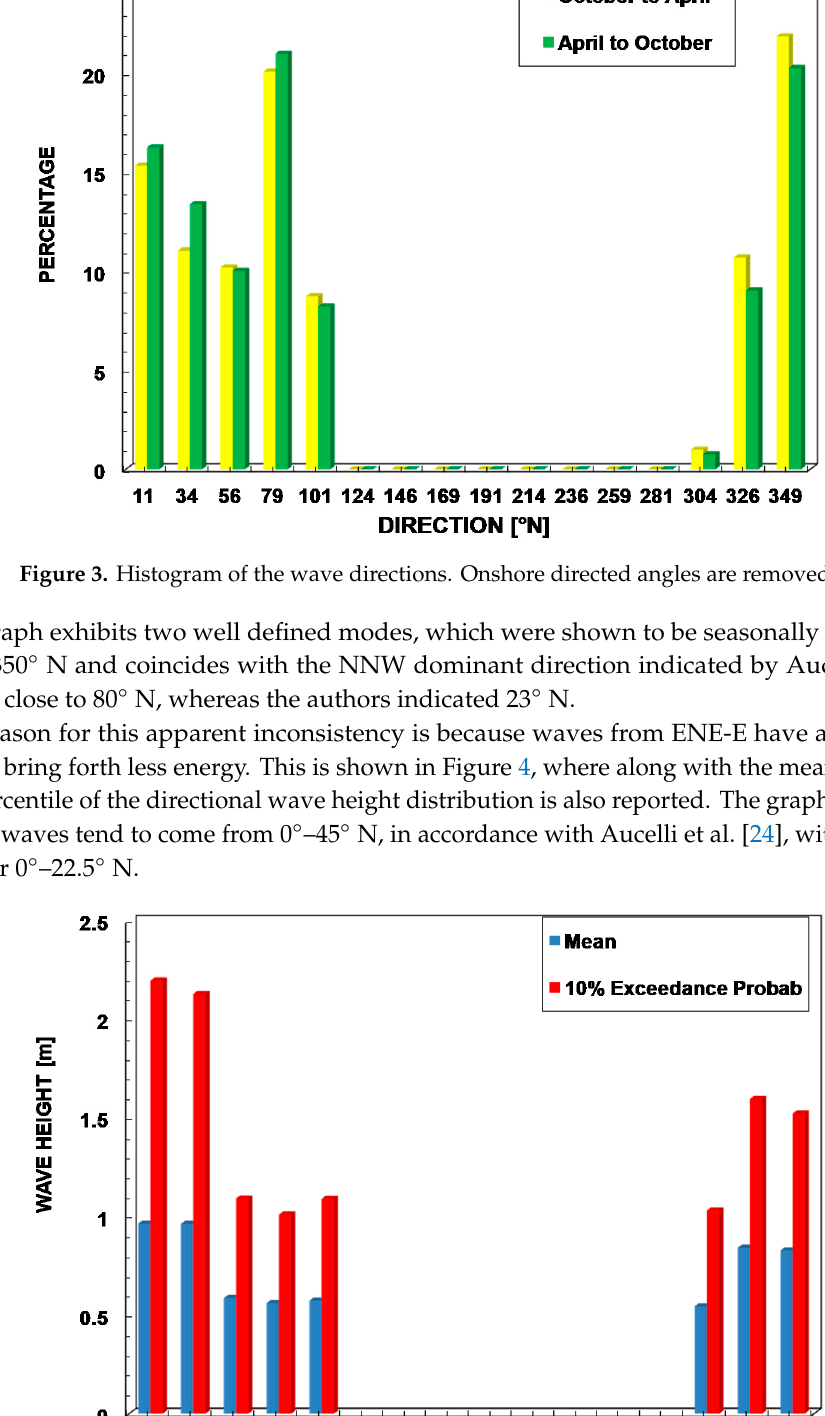
Figure 4. Directional distribution of mean and 90th percentile wave height.